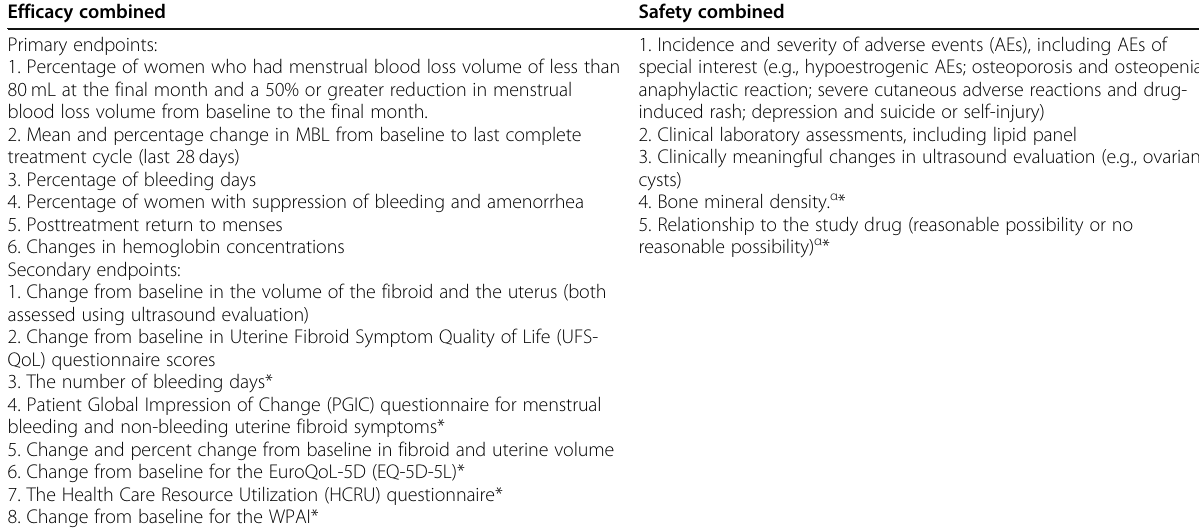
Table 2 Outcomes assessed Efficacy combined Safety combined